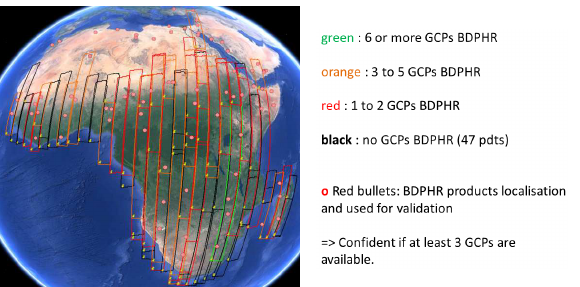
Figure 12. BDPHR number per South Africa GRI products.